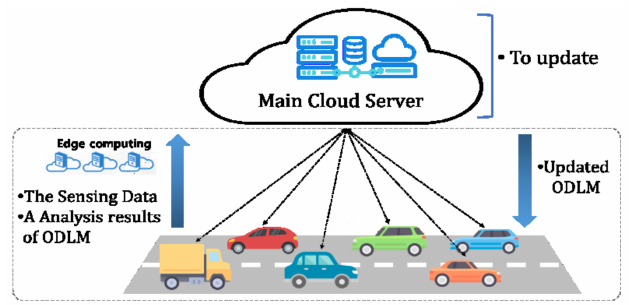
Figure 9. The structure of the Edge Computing based Self-diagnosis Service (ECSS).